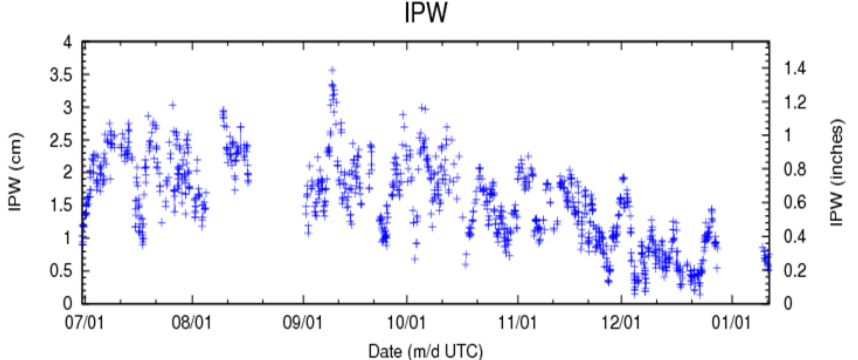
Figure 5. Time series of the integrated precipitable water (IPW) content (both in cm and inches) retrieved during the from 1 July 2013 to 16 January 2014 year 2013 at CIAO using the GPS technique. The processing of GPS data is provided by NOAA/GSD Ground-Based GPS Meteorology